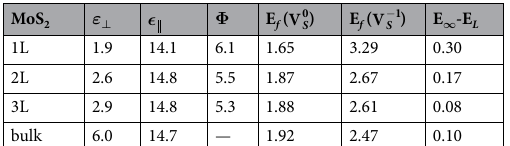
Table 2. Results obtained from DFT calculations for the dielectric constants (perpendicular, ⊥  , and parallel,  , to the layers), work function ( Φ ), and formation energies of the neutral and singly negatively S vacancy in monolayer (1L), bilayer (2L), tri-layer (3L), and bulk MoS 2 . The last column reports the energy corrections for the formation energies of the charged defects obtained by using the method presented in this work. Energy values are in eV.